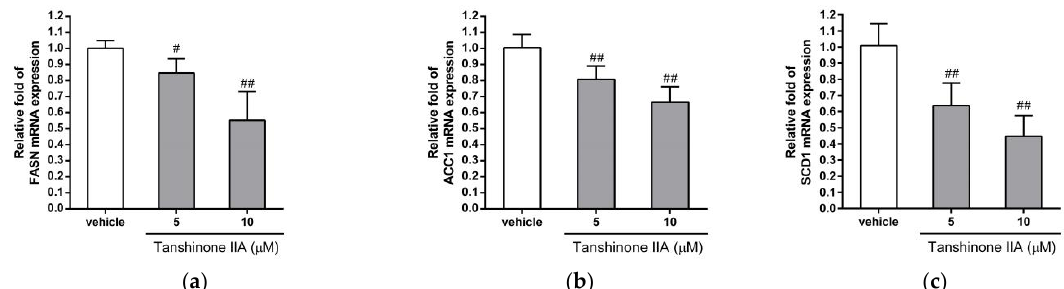
Figure 2. Effects of tanshinone IIA on FASN, ACC1, and SCD1 mRNA expression in HepG2 cells. HepG2 cells were treated with vehicle (0.1% DMSO) or tanshinone IIA (5 and 10 μM) for 24 h. The mRNA expression of ( a ) FASN, ( b ) ACC1, and ( c ) SCD1 was measured by RT-qPCR analysis. The data represent the mean ± SD of three independent experiments. # p < 0.05 and ## p < 0.01 indicate significant differences compared to the vehicle-treated cells.